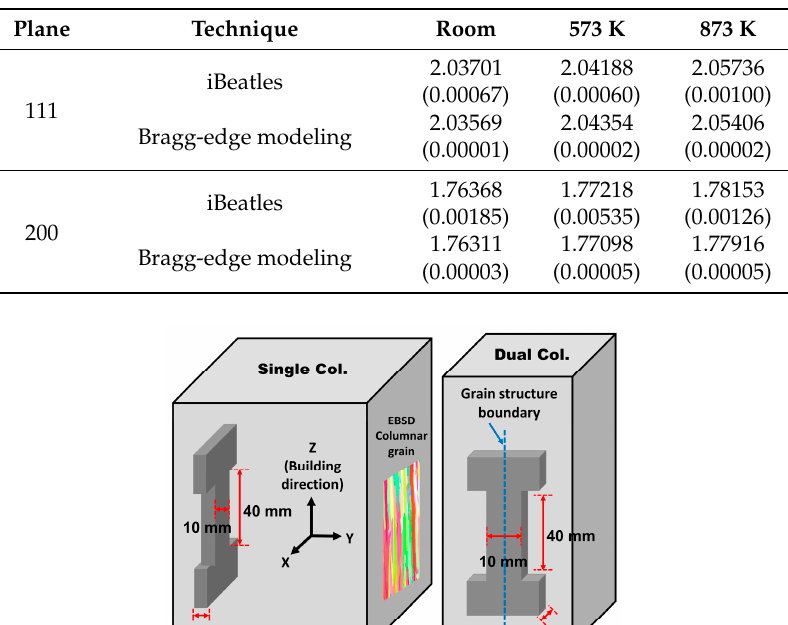
Figure 3. ( a ) Measured transmission spectra of a pure Ni powder sample during in situ heating to 873 K. Neutron transmission radiograph in ( a ) is displayed at a wavelength near the (200) Bragg edge. ( b ) Plot of thermal lattice strains as a function of temperature and linear fittings of the pure Ni powder based on the interplanar spacing values obtained by the iBeatles (red circles) and Bragg-edge modeling (black squares), respectively. Table 3. The (111) and (200) interplanar spacings (in Å) of pure Ni powder sample at room temperature, 573, and 873 K obtained by iBeatles and Bragg-edge modeling fittings. The values in parentheses represent the fitting error.